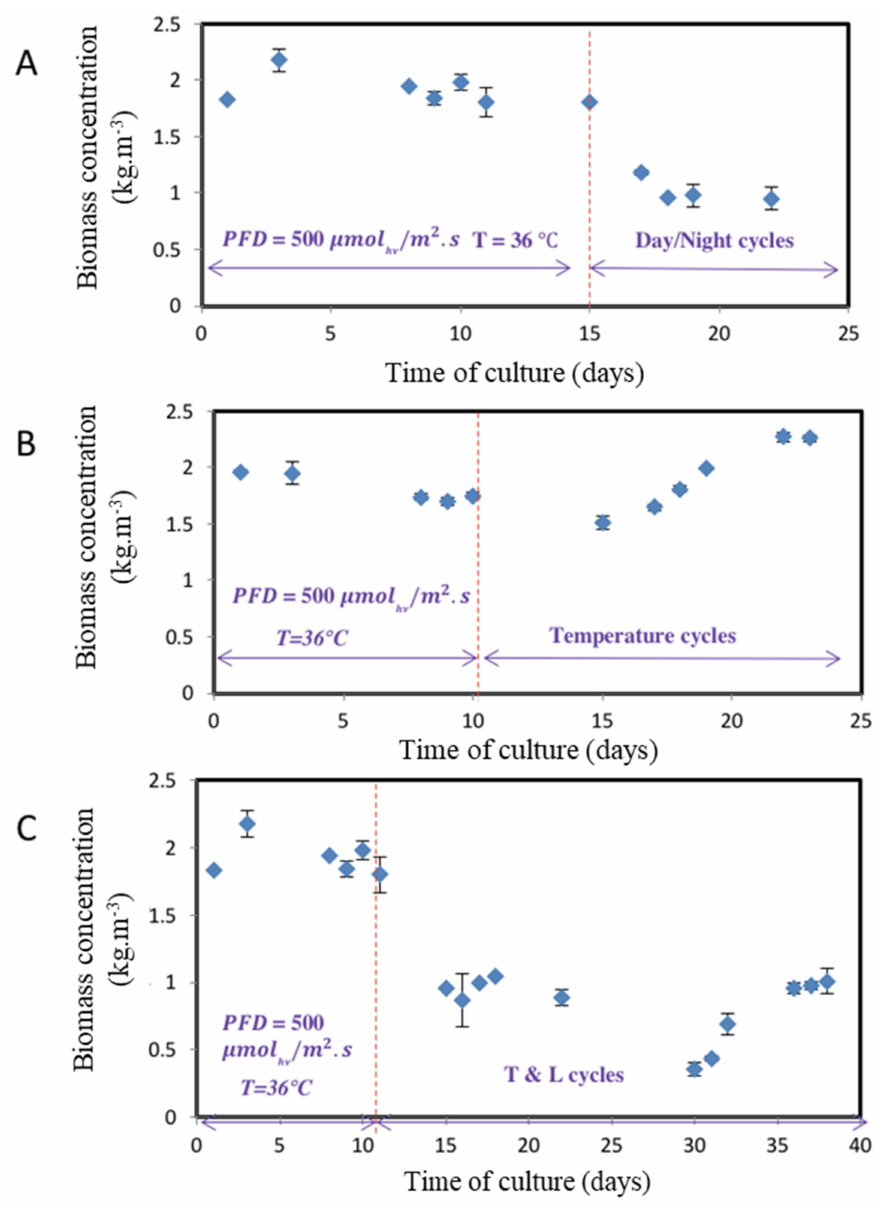
Figure 4. Time acclimation of N . sp. QU130 under three different cultivation cycles stresses, ( A ): Cultivation under day/night cycles (Experiment C); ( B ): Cultivation under temperature fluctuation (Experiment B) and ( C ): Cultivation under combined light and temperature cycles (Experiment